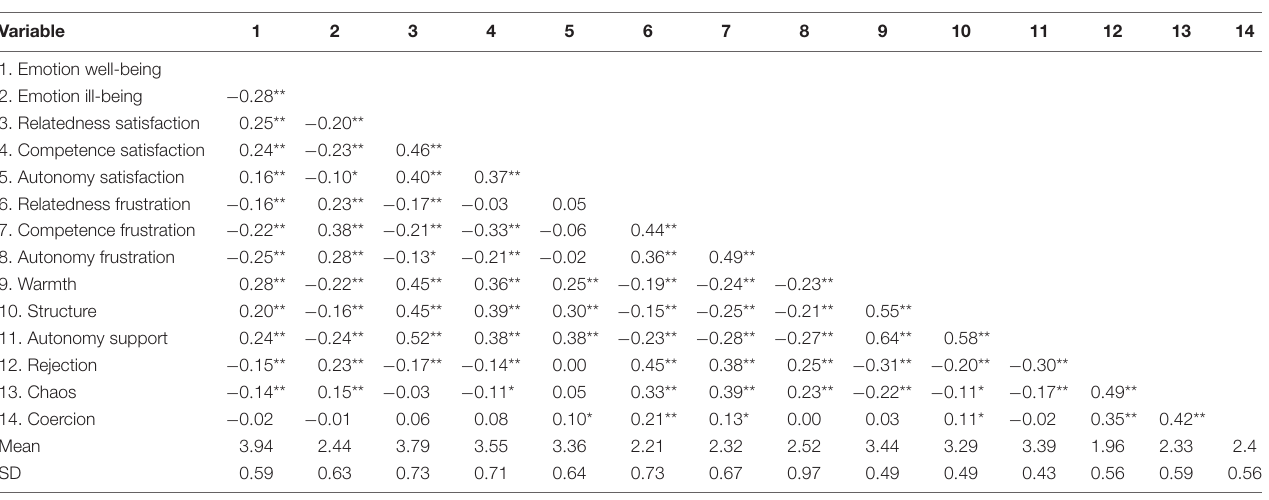
TABLE 1 | Means, standard deviations, and correlations between measurement variables.